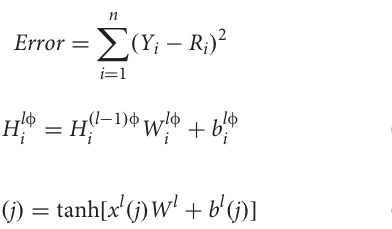
respectively. The hyperbolic tangent function is used as